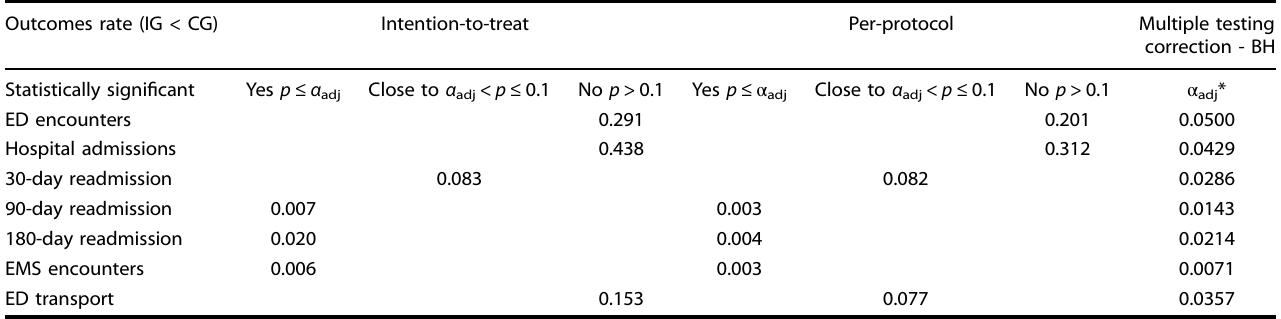
Table 6. Comparison of study outcomes from intention-to-treat and per-protocol analyses.